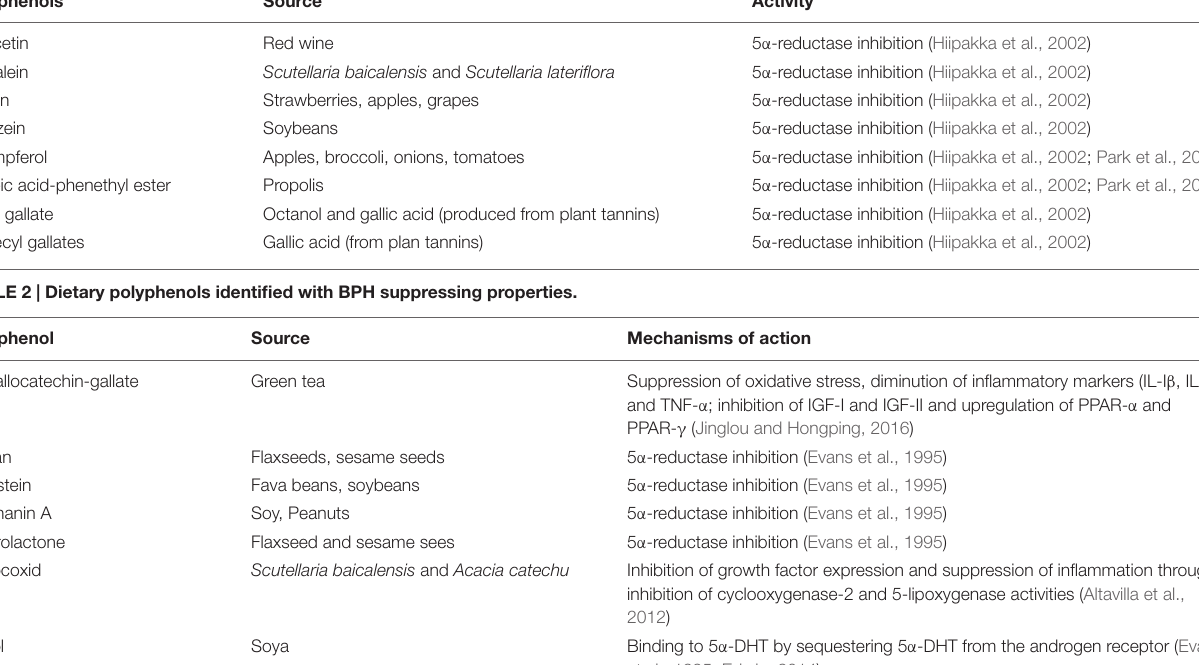
TABLE 1 | Dietary polyphenols identified with 5 α -reductase inhibitory actions.